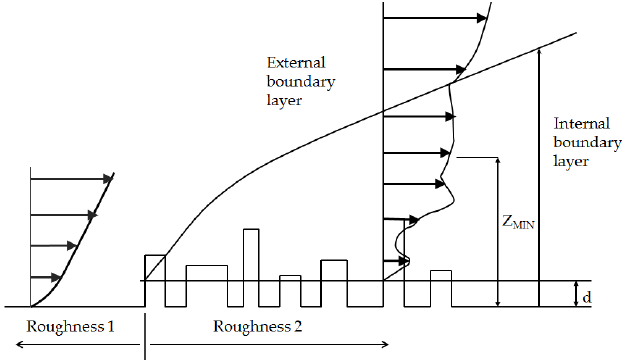
Figure 1. Wind profile in the internal boundary layer in a built environment [6].